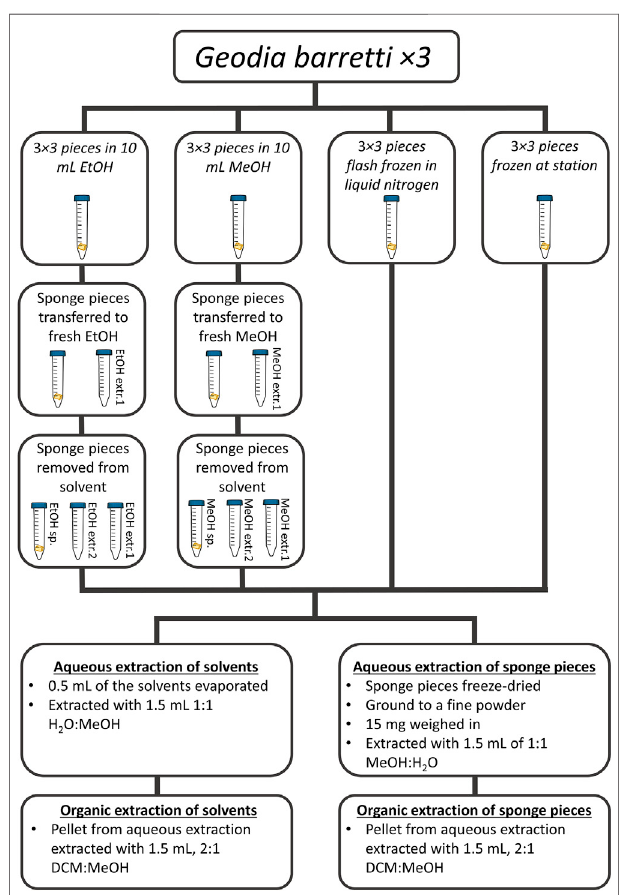
FIGURE 1 | A summary of the collected samples and the treatments aftersamplingaswellasextraction.Intotalthreespecimensof G.barretti were collected, from each specimen three pieces were taken for each of the